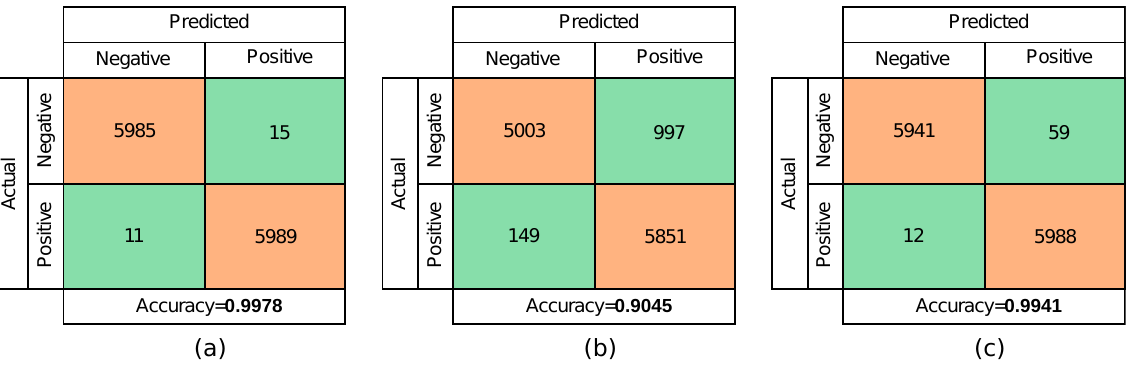
Figure 8. Confusion matrices showing different network accuracy when: ( a ) the model is trained on the original Mendeley “Concrete Crack Images for Classification” data set and tested on concrete images without shadows; ( b ) the model is tested on concrete images with shadows; ( c ) the model is trained on the augmented Mendeley “Concrete Crack Images for Classification” data set and tested on concrete images without